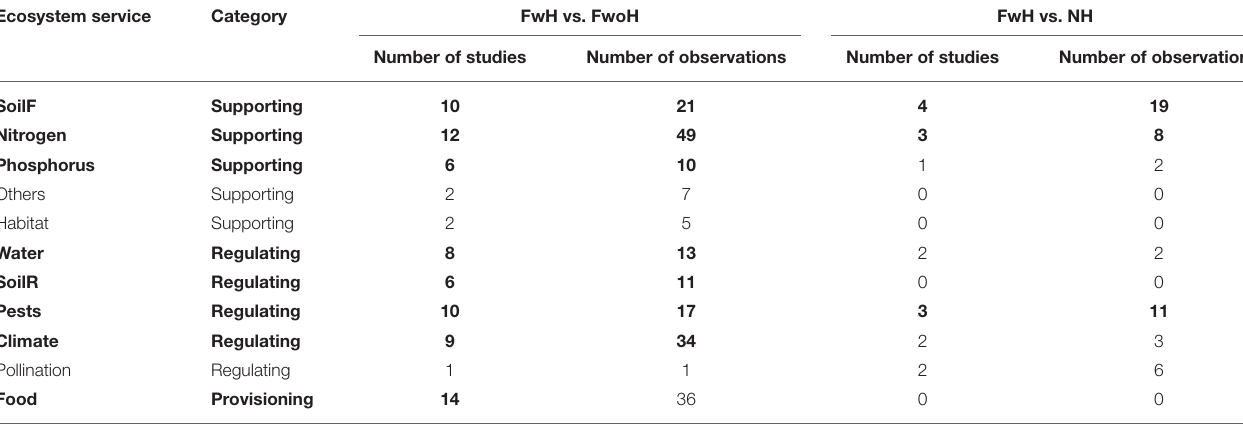
TABLE 1 | Number of primary studies and observations providing data for specific ecosystem services. Ecosystem service Category FwH vs. FwoH FwH vs. NH